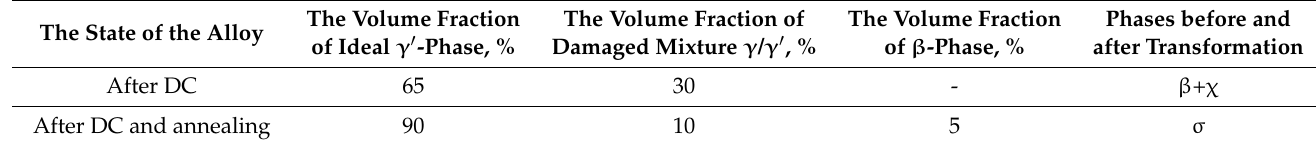
Table 7. Quantitative phase compositions of